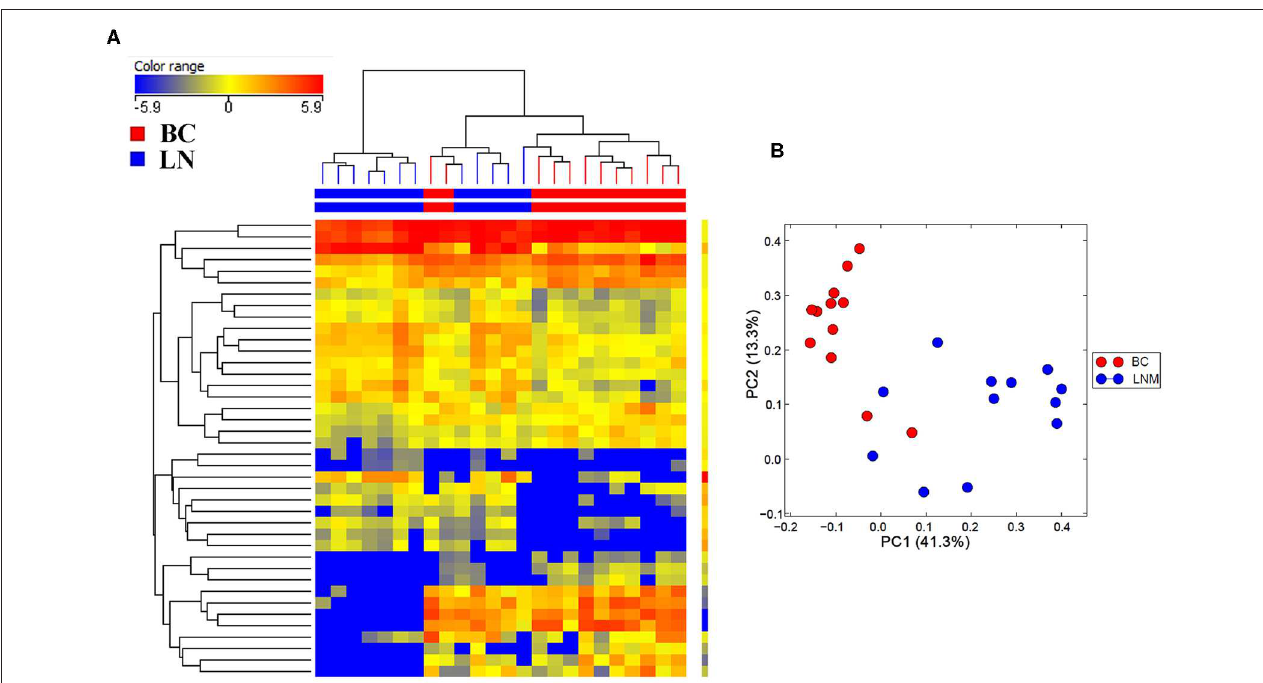
FIGURE 1 | Hierarchical clustering depicting the expression of differentially expressed miRNAs in lymph node metastatic (LNM) and matched primary breast cancer (BC). (A) Hierarchical clustering of 12 LNM and 12 matched primary BC tissue based on differentially expressed miRNA levels. Each column represents a sample and each row represents a miRNA. Expression level of each miRNA in a single sample is depicted according to the color scale. (B) Principal component analysis (PCA) for the miRNA transcriptome of 12 LNM and their matched BC